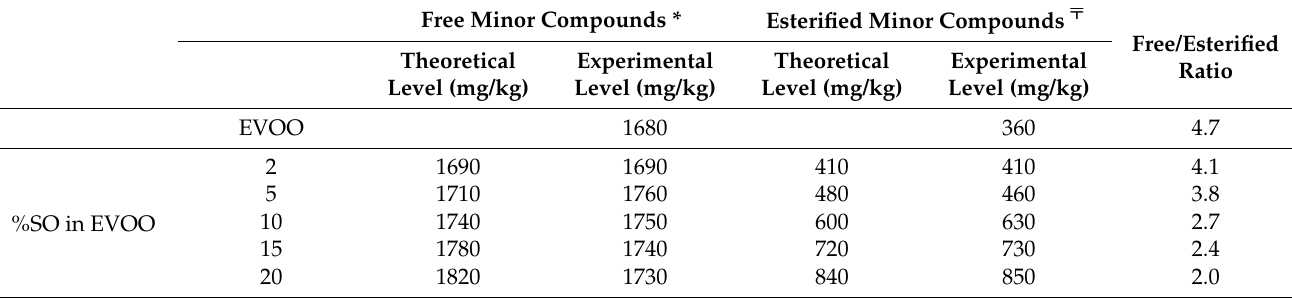
Figure 2. SPE-GC-FID chromatograms of TMS free and esterified HMC profiles of pure EVOO containing different percentages of RSO (2–20%). The expansion of the esterified minor compounds peak group is shown in the box. Table 3. Content of free and esterified HMC (mg/kg) and ratio in pure EVOO and EVOO containing different percentages of RSO